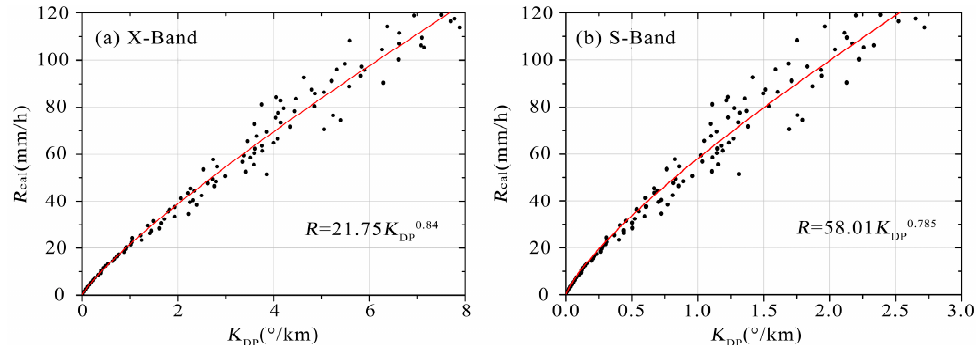
Figure 2. R ( K DP ) relationship for X-band ( a ) and S-band ( b ) radars, derived by the least squares method of the observations. Table 1. The coefficients of the R ( Z h ) and R ( K DP ) for X-band and S-band dual-polarization radars in South China fitted by DSD data in Foshan.